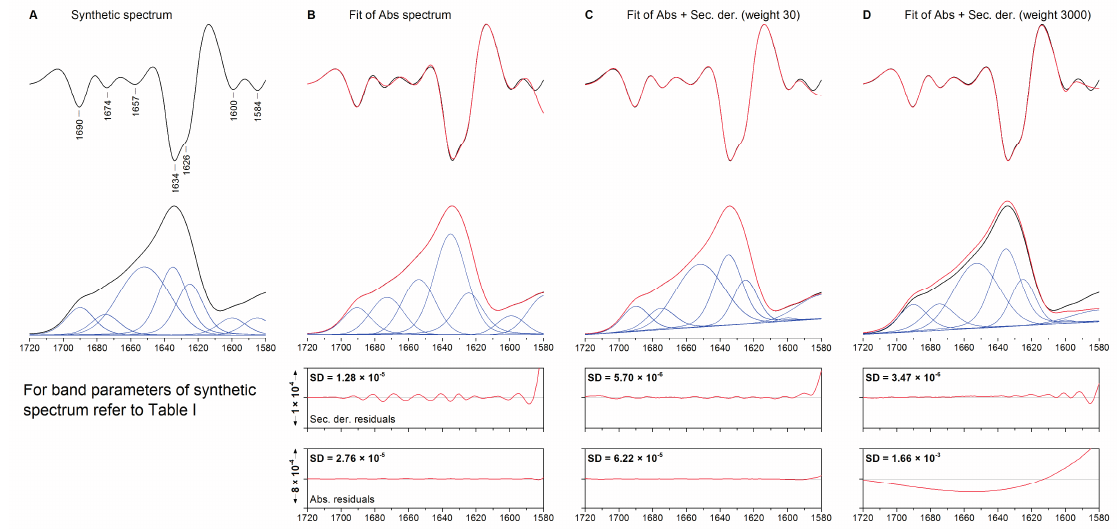
Figure 1. ( A ) Synthetic spectrum obtained using the spectral parameters defined in Table 1. ( B ) Fitting of the absorption spectrum only; ( C – D ) simultaneous fitting of the absorption and second derivative spectra using the same set of initial spectral parameters and weight factors of 30 and 3000. From top to bottom: second derivative, absorption spectra, residuals for the second derivative spectrum, and residuals for the absorption spectrum. Original spectra are shown black, fitted spectra in red. The individual bands are shown in